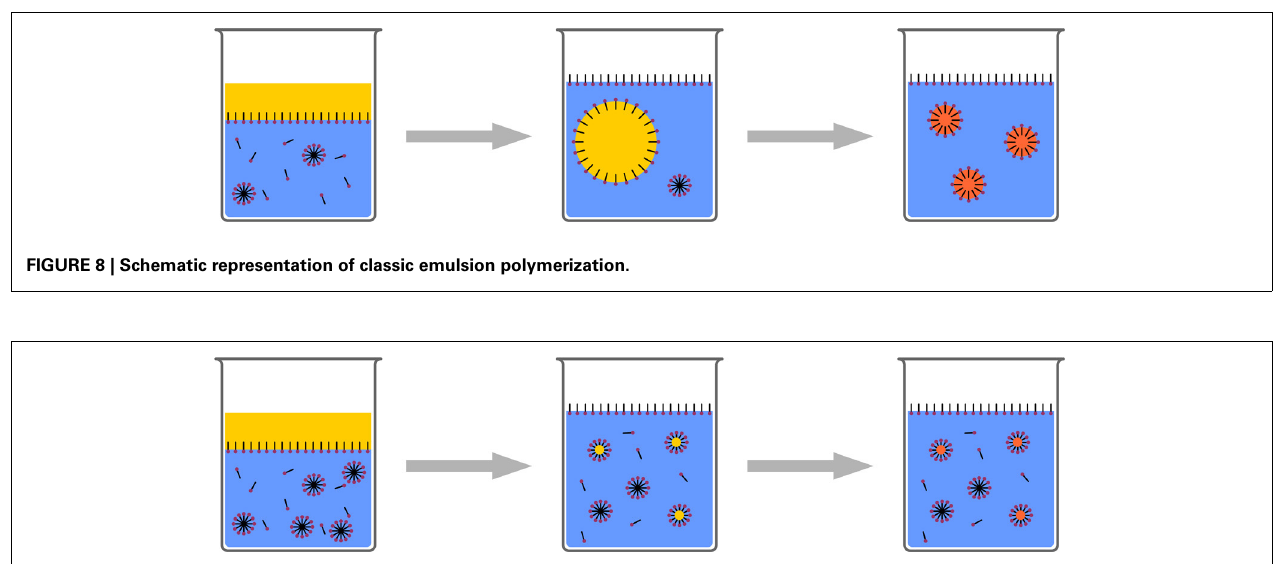
FIGURE 9 | Schematic representation of microemulsion polymerization. Radical polymerization in very highly concentrated surfactant/co-surfactant solution leads to ultrasmall polymeric nanoparticles.